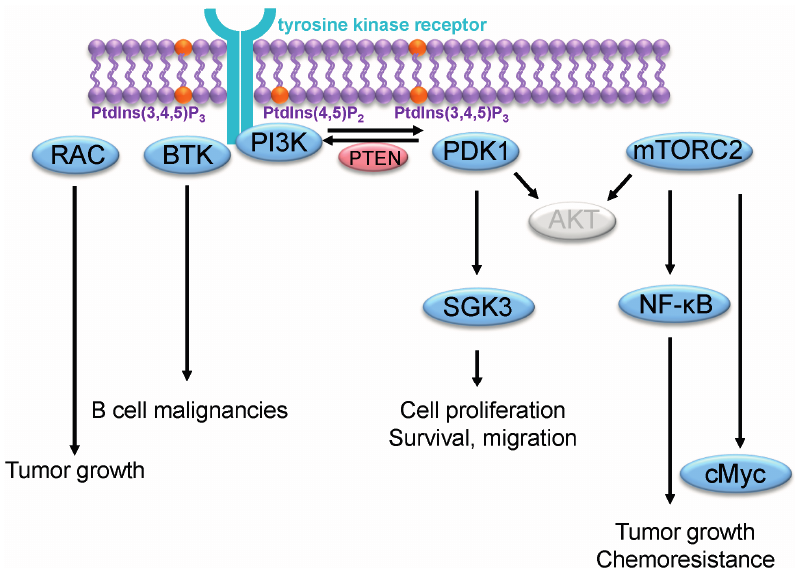
Figure 2. AKT-independent PI3K signaling in cancer. Several AKT-independent mechanisms used by PI3K to promote cancer growth have been described. They include activation of RAC, BTK in B cell malignancies, PDK1/SGK3 and mTORC2/NF- κ B; mTORC2/c-Myc. Light gray ovals imply components of the signaling pathway that are not activated or